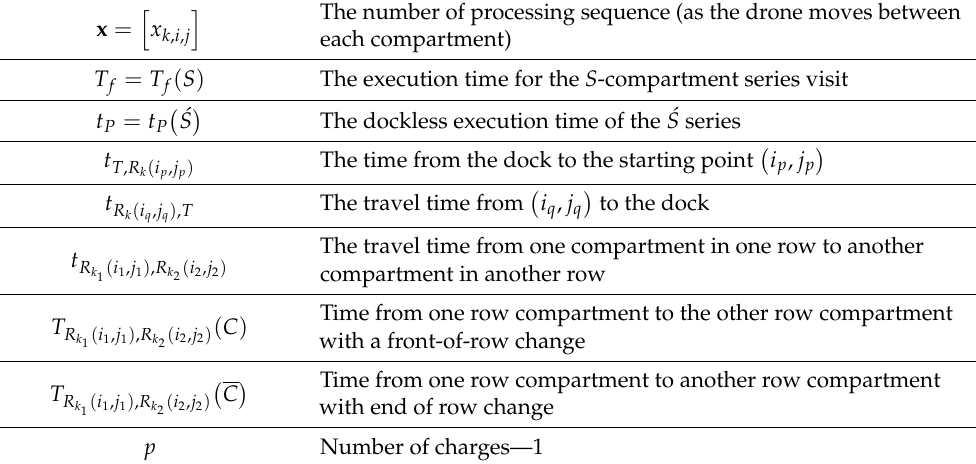
Table 3. Summary and notation of variable